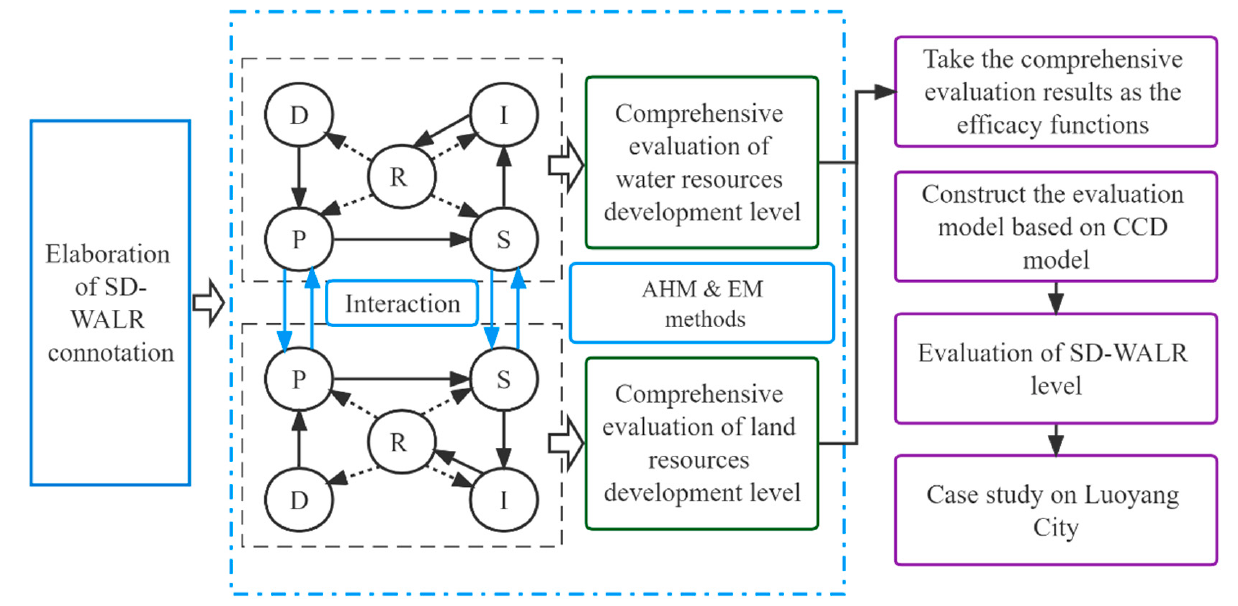
Figure 1. Research ideas and steps on the evaluation of the SD-WALRs.